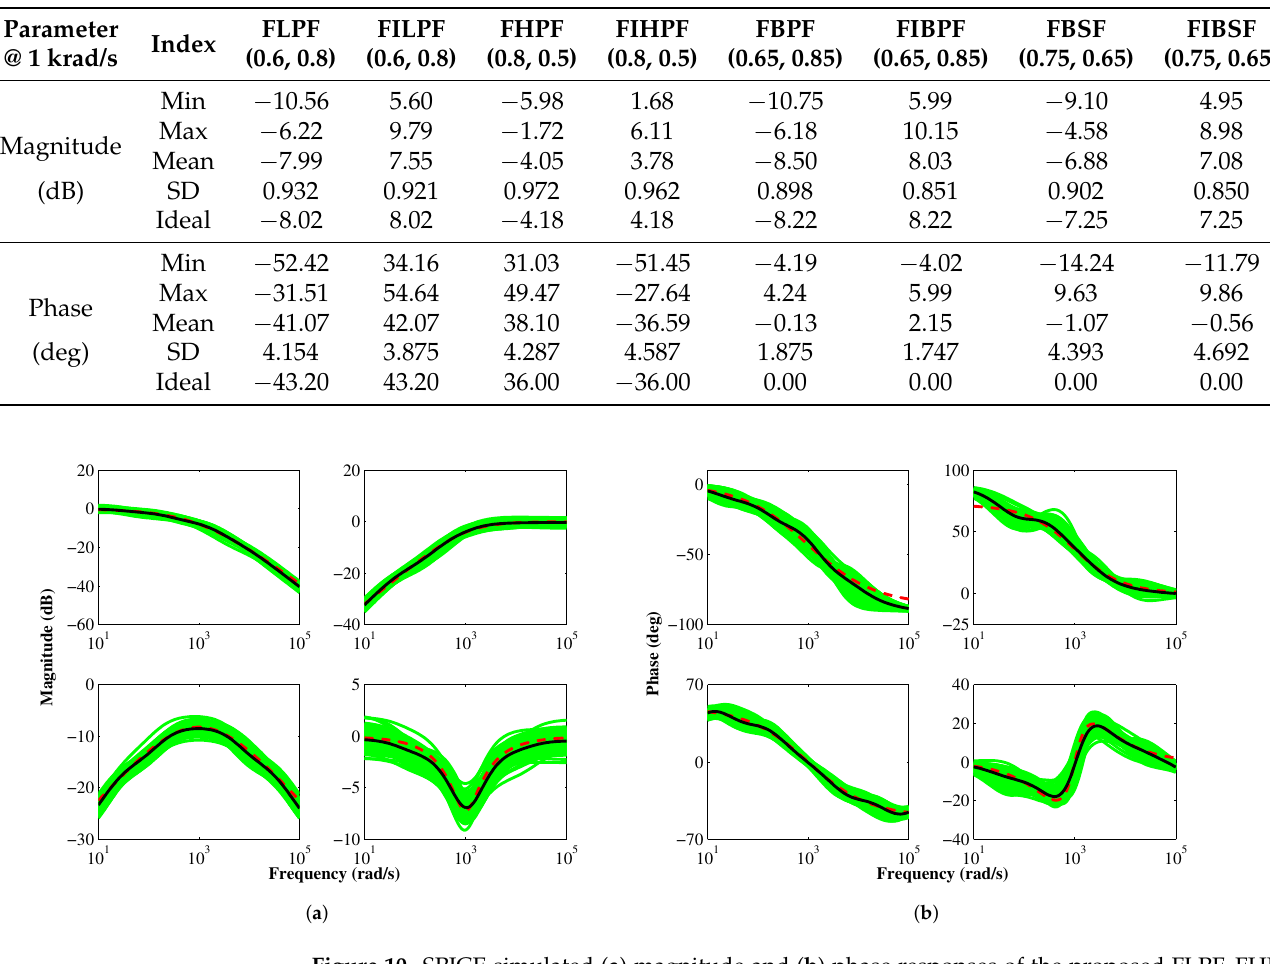
Table 14. Statistical indices about the magnitude/phase at the shift frequency of the designed filters based on 100 Monte-Carlo simulation runs.